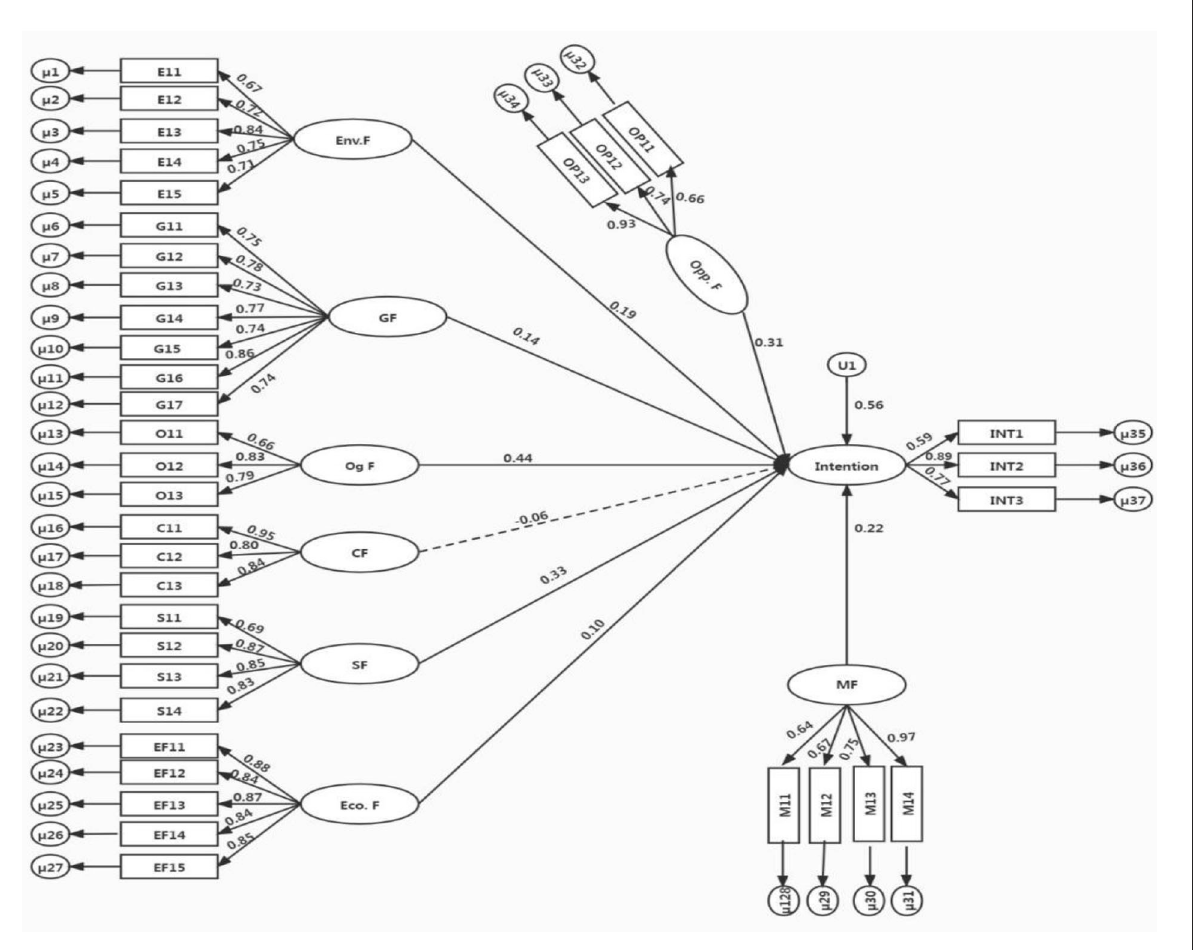
FIGURE3 The results of the